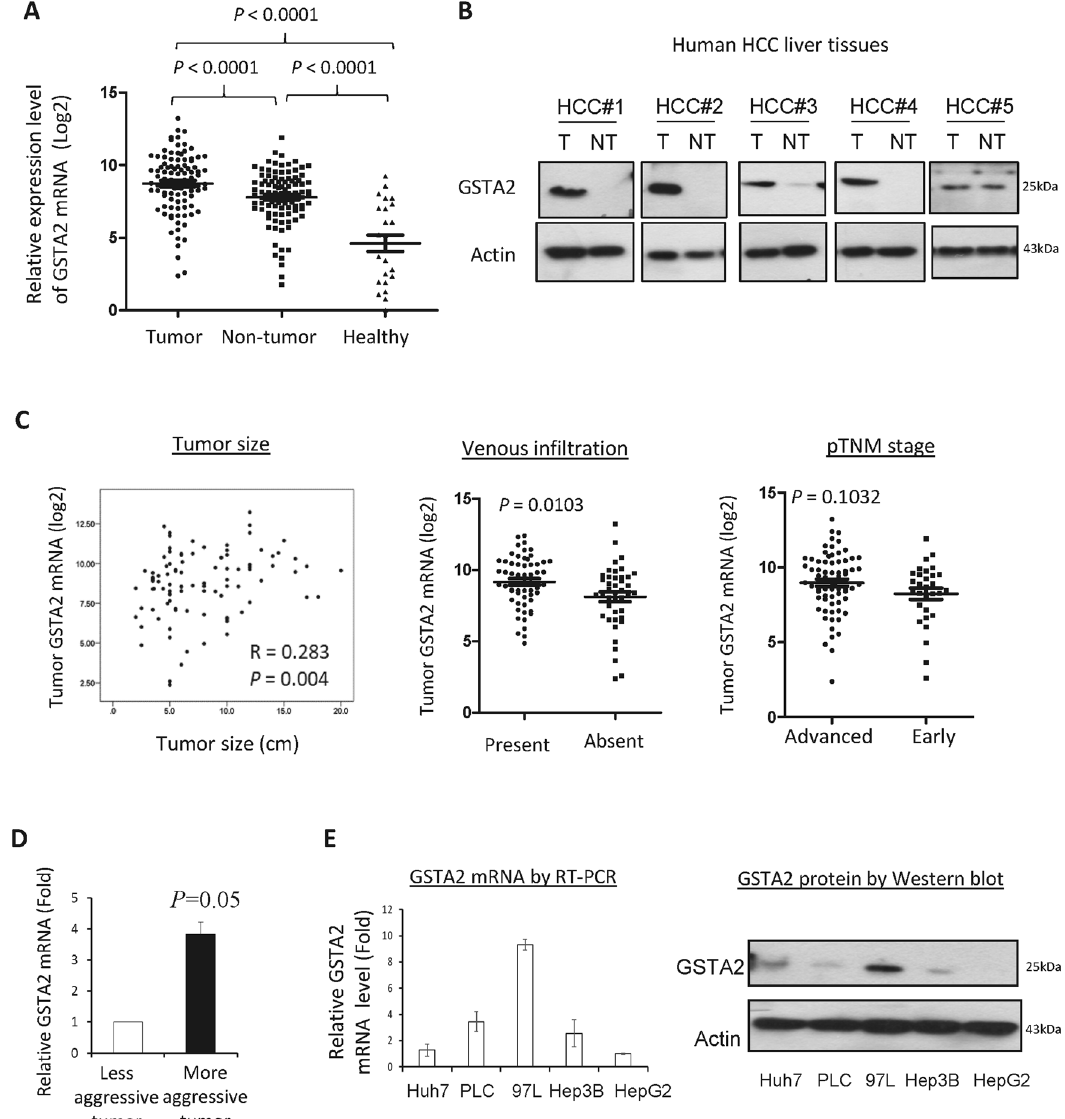
Fig. 4 The expression signi fi cance of GSTA2 in HCC. A Expression of GSTA2 mRNA in the tumor (T) and non-tumor (NT) liver tissues of HCC patients, and in the liver tissues of healthy donors. B Western blot analysis of GSTA2 protein in paired tumor (T) and non-tumor (NT) tissues of HCC patients. C The correlation analysis of the expression level of tumoral GSTAs mRNA and tumor size, the presence of venous in fi ltration, and pTNM stage of HCC patients. D The expression level of tumoral GSTA2 mRNAs between less aggressive and more aggressive tumors after liver transplantation in rats. E The expression of GSTA2 mRNA and protein among different HCC cell